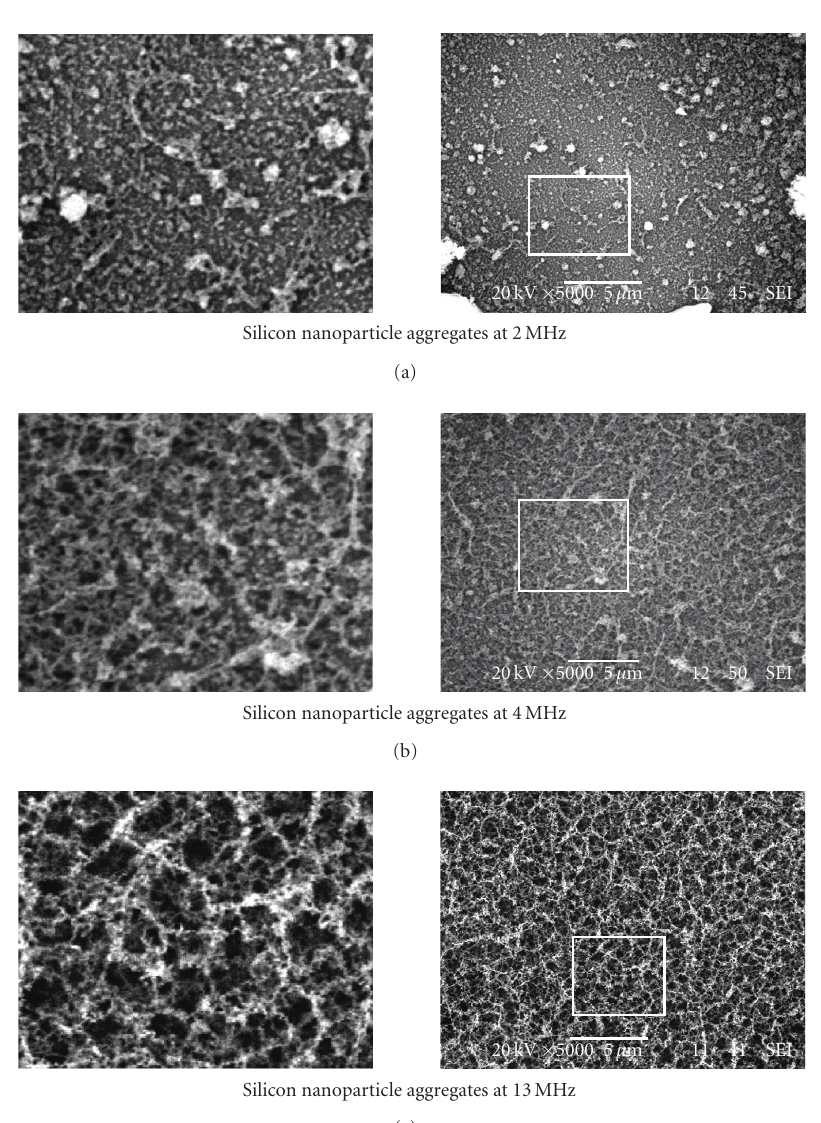
Figure 2: Silicon nanoparticle aggregate growth with laser pulse